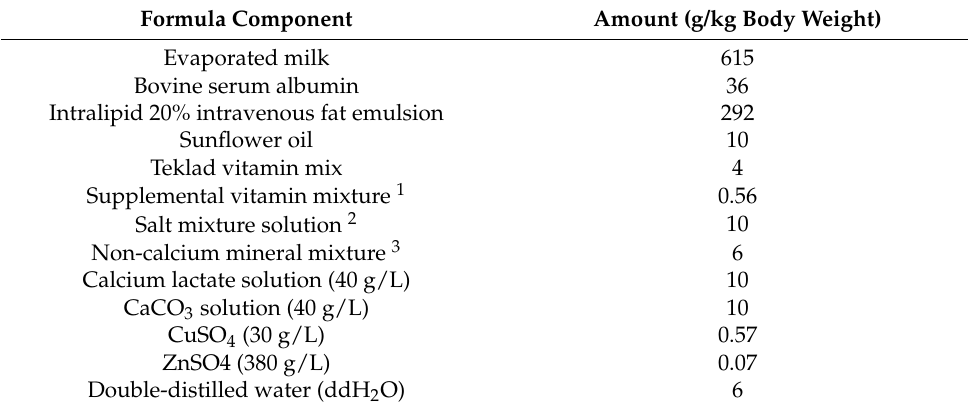
Table 1. Rodent milk substitute (RMS) composition (modified from